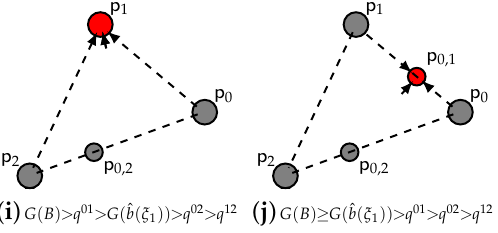
Figure 5. Dynamics for the case of convex f ( (cid:96) ) and three available strategies/ S = { 0,1,2 }